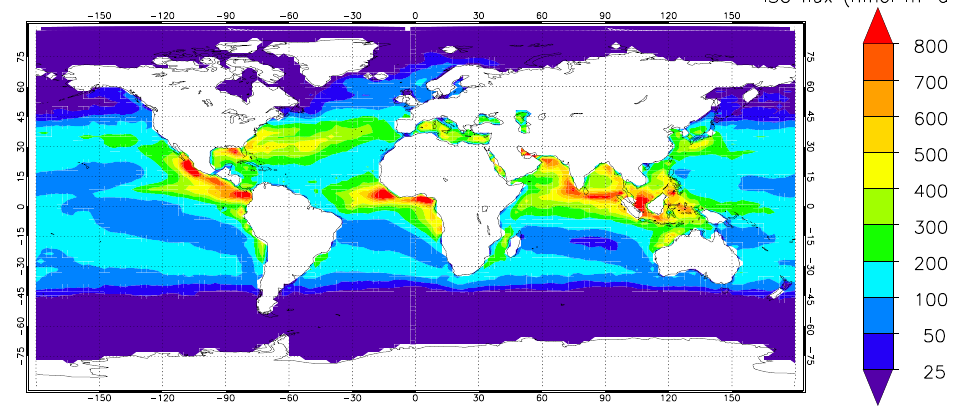
Figure 2. Modelled annual mean ocean flux of ISG. Following the laboratory work of Carpenter et al. (2013) and MacDonald et al. (2014), the parameterisation of the ISG flux given by Eqs. (1)–(4) was newly implemented in the global chemistry–climate model CAM-Chem.